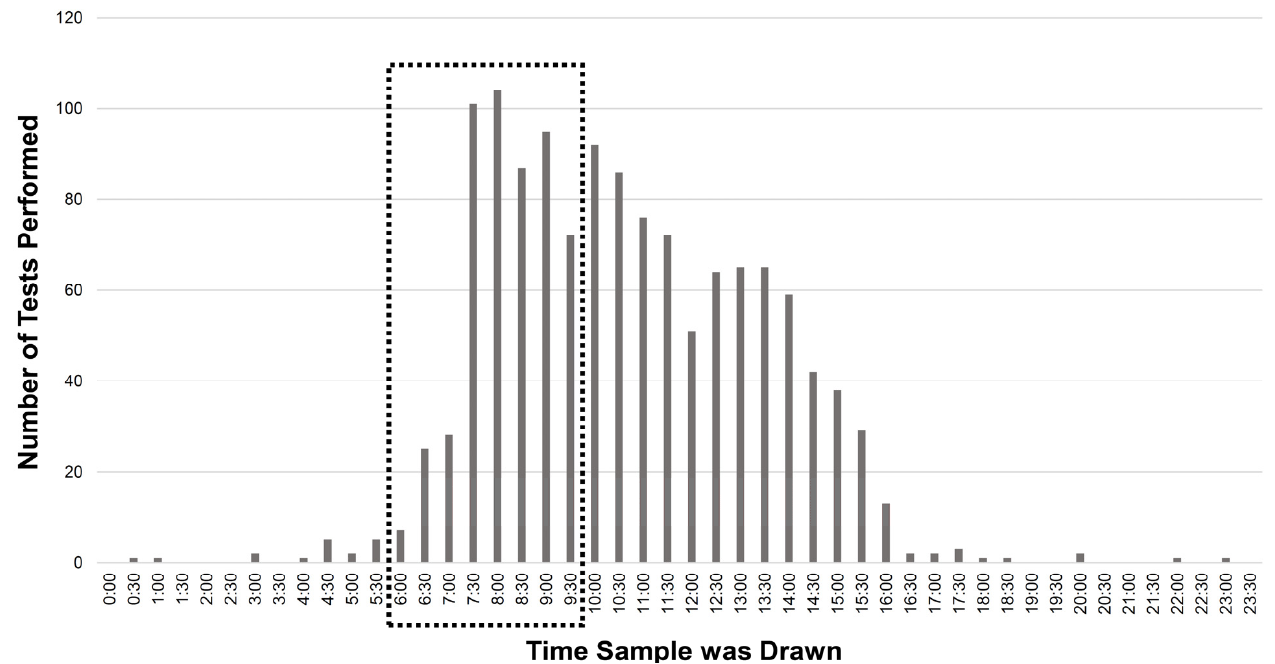
Figure 1. Number of serum cortisol tests performed by time in the sample population. The black rectangle highlights the tests which were drawn at the correct time.